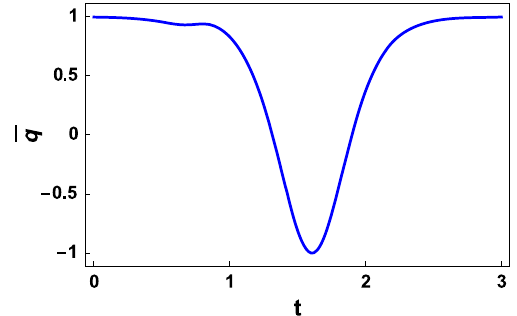
Fig. 2 Time evolution of the analytical acceleration parameter derived from a three-field model These previous solutions together with (71) allow us